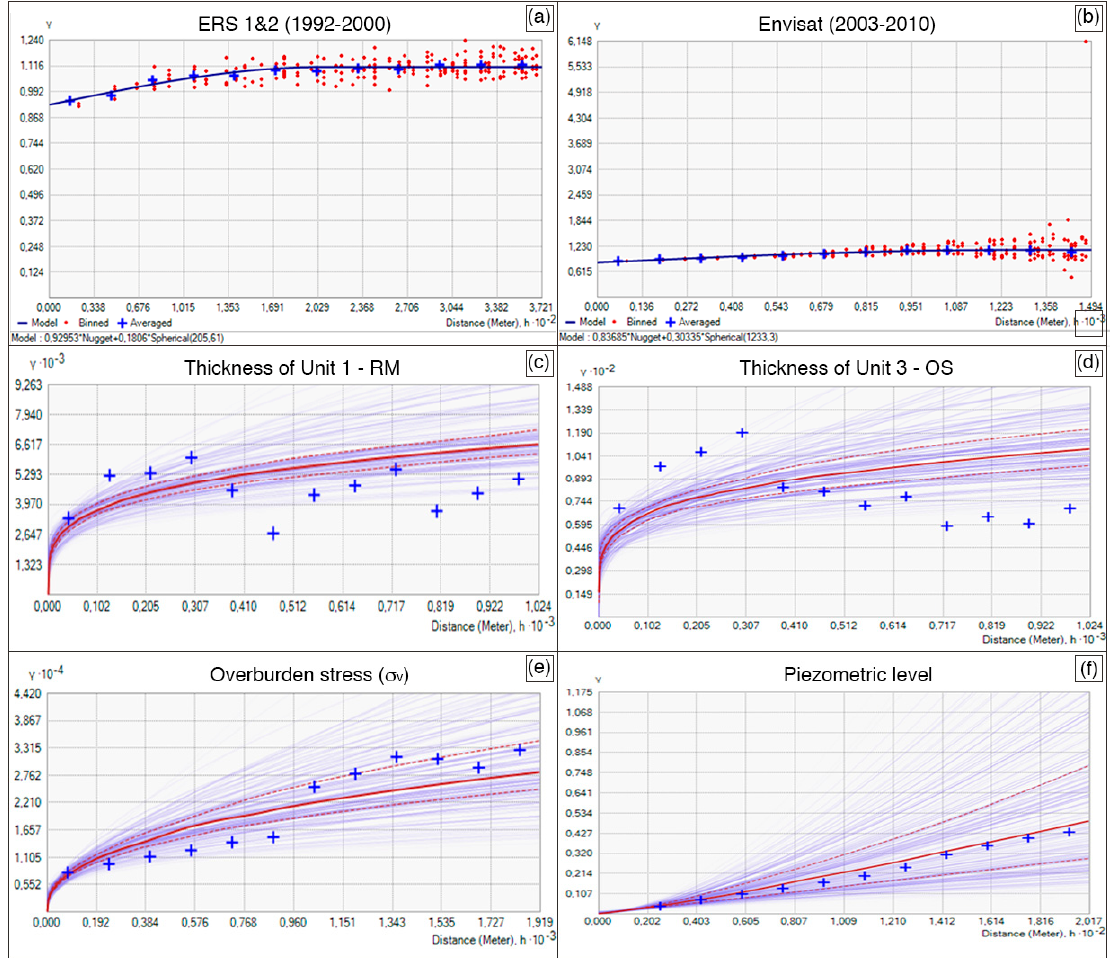
Figure A1. Semivariogram of ( a ) ERS 1 and 2 (1992–2000) and ( b ) Envisat (2003–2010) vertical velocity values interpolated via ordinary kriging. ( c ) The thickness of unit 1 (RM), ( d ) thickness of unit 3 (OS), ( e ) overburden stress ( σ v ), and ( f ) piezometric level, which were interpolated via Empirical Bayesian Kriging.